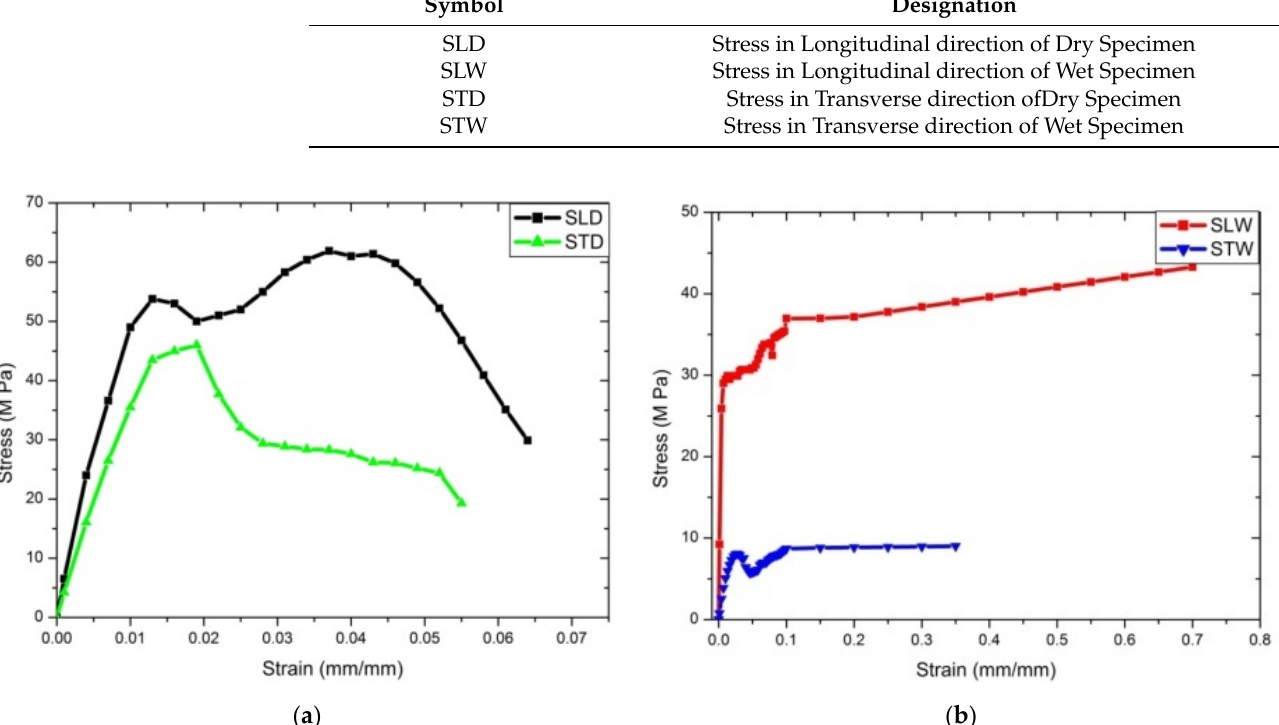
Table 2. Nomenclature for coupons developed for mechanical properties. Symbol